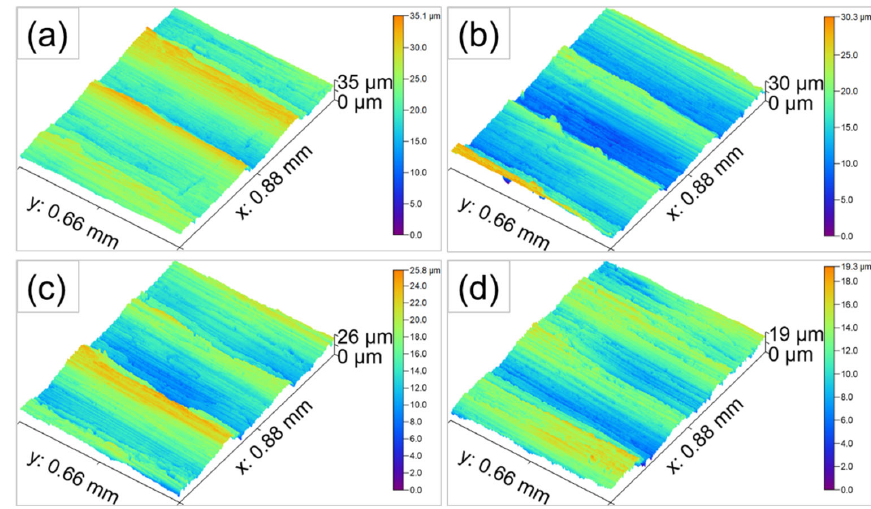
Figure 6. Surface topography of the machined surface using CCI: ( a ) CT; ( b ) 0.42 A/mm 2 ; ( c ) 0.57 A/mm 2 ; and ( d ) 0.90 A/mm 2 .